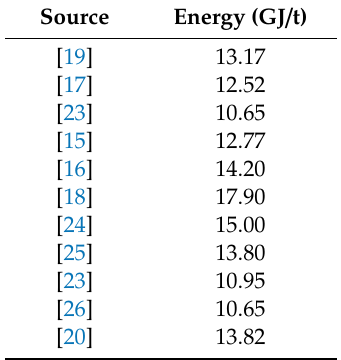
Table 2. Alumina refining energy per ton of alumina.